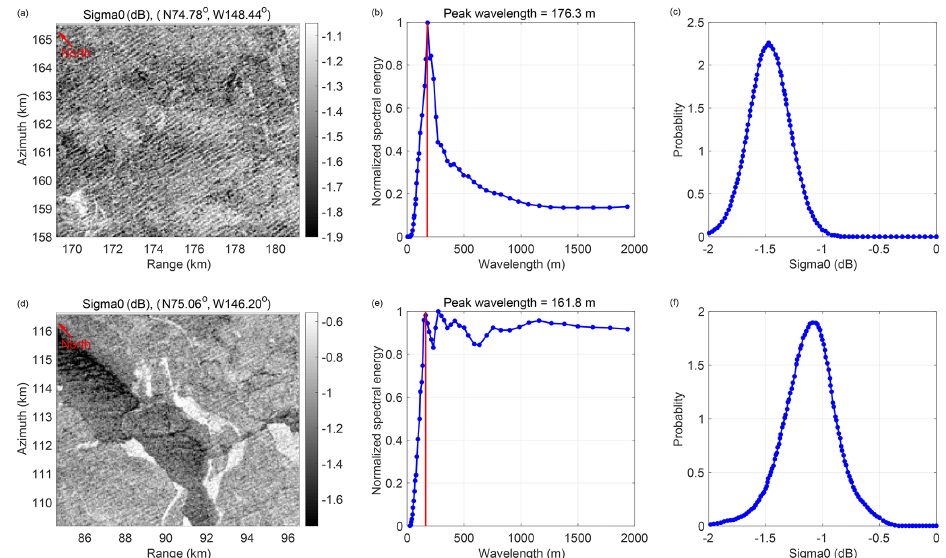
Figure A1. Illustration of the process to determine the FAL using two representative SAR subimages. (a, d) Surface SAR subimage roughness for a case locatedbefore the FAL (a, b, c) and a case located after the FAL (d, e, f) . (b, e) Normalized spectral energy (normalized by the maximum energy within the 100–300m wavelengths) of the SAR subimages, where the red line indicates the dominant wavelength. (c, f) The probability density function of the SAR roughness (backscatter or sigma0 of thermal noise in the SAR imagery) for the two